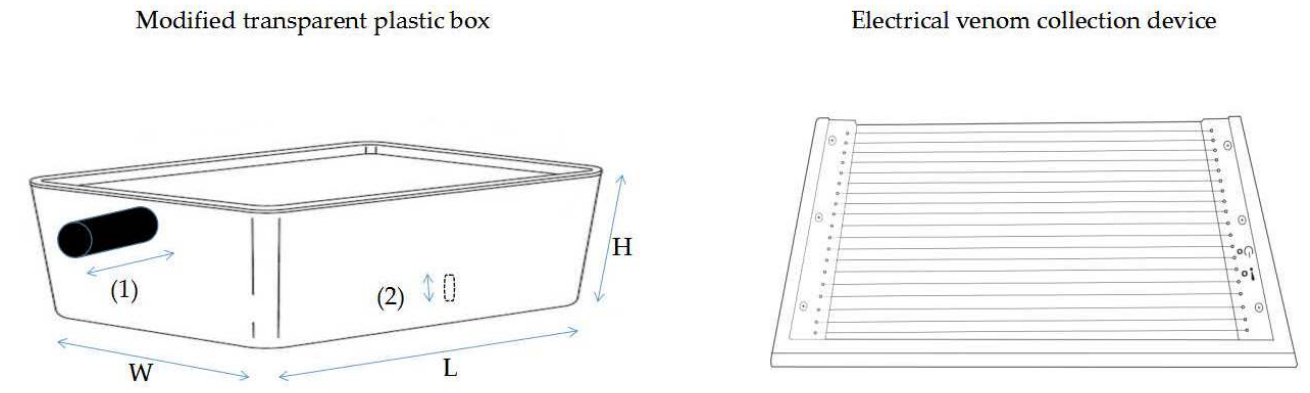
Figure 10. System set-up for Vespa velutina venom obtention chamber by electric